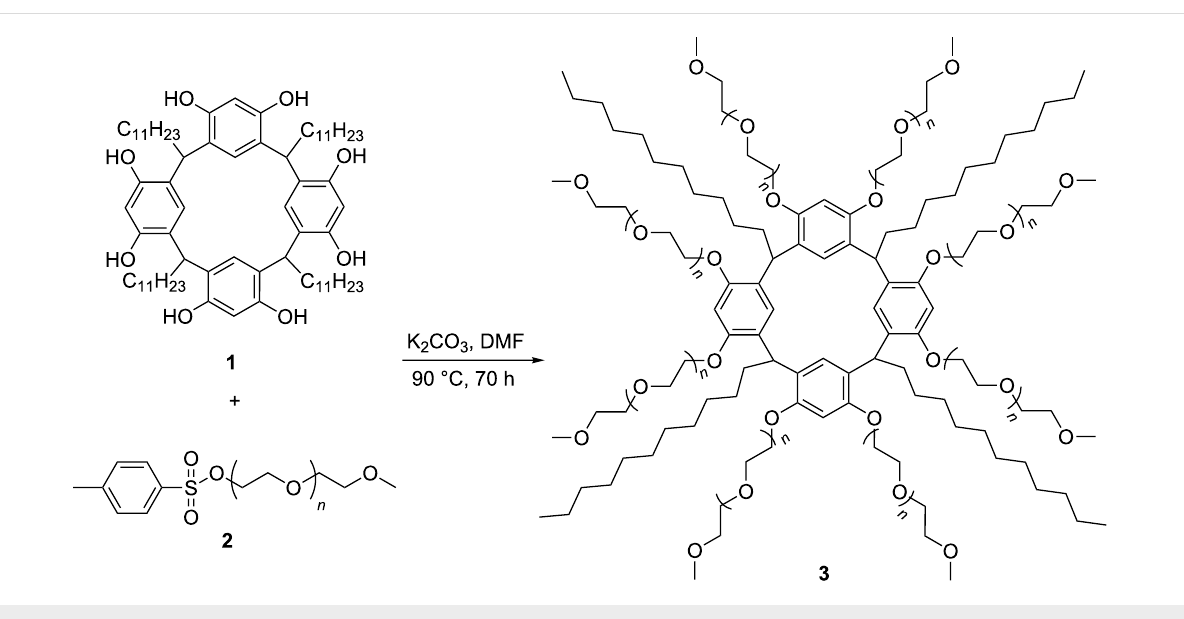
Scheme 1: Synthesis of tetraundecylcalix[4]resorcinarene–mPEG conjugate 3